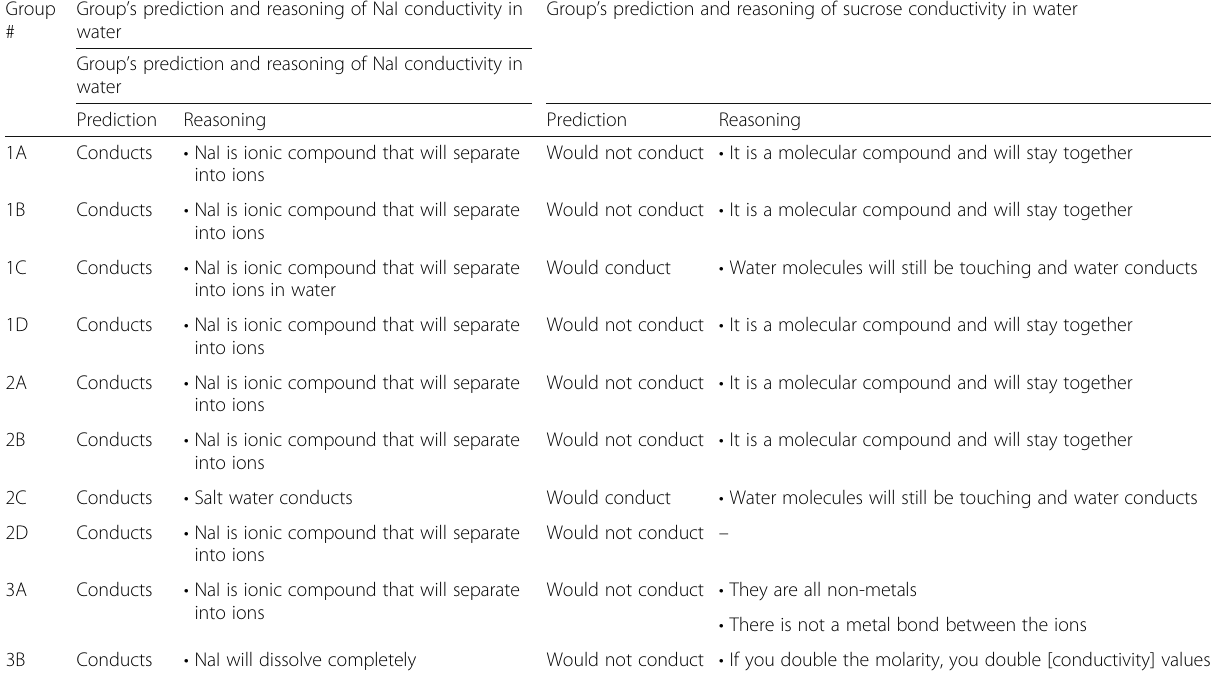
Group ’ s prediction and reasoning of sucrose conductivity in water